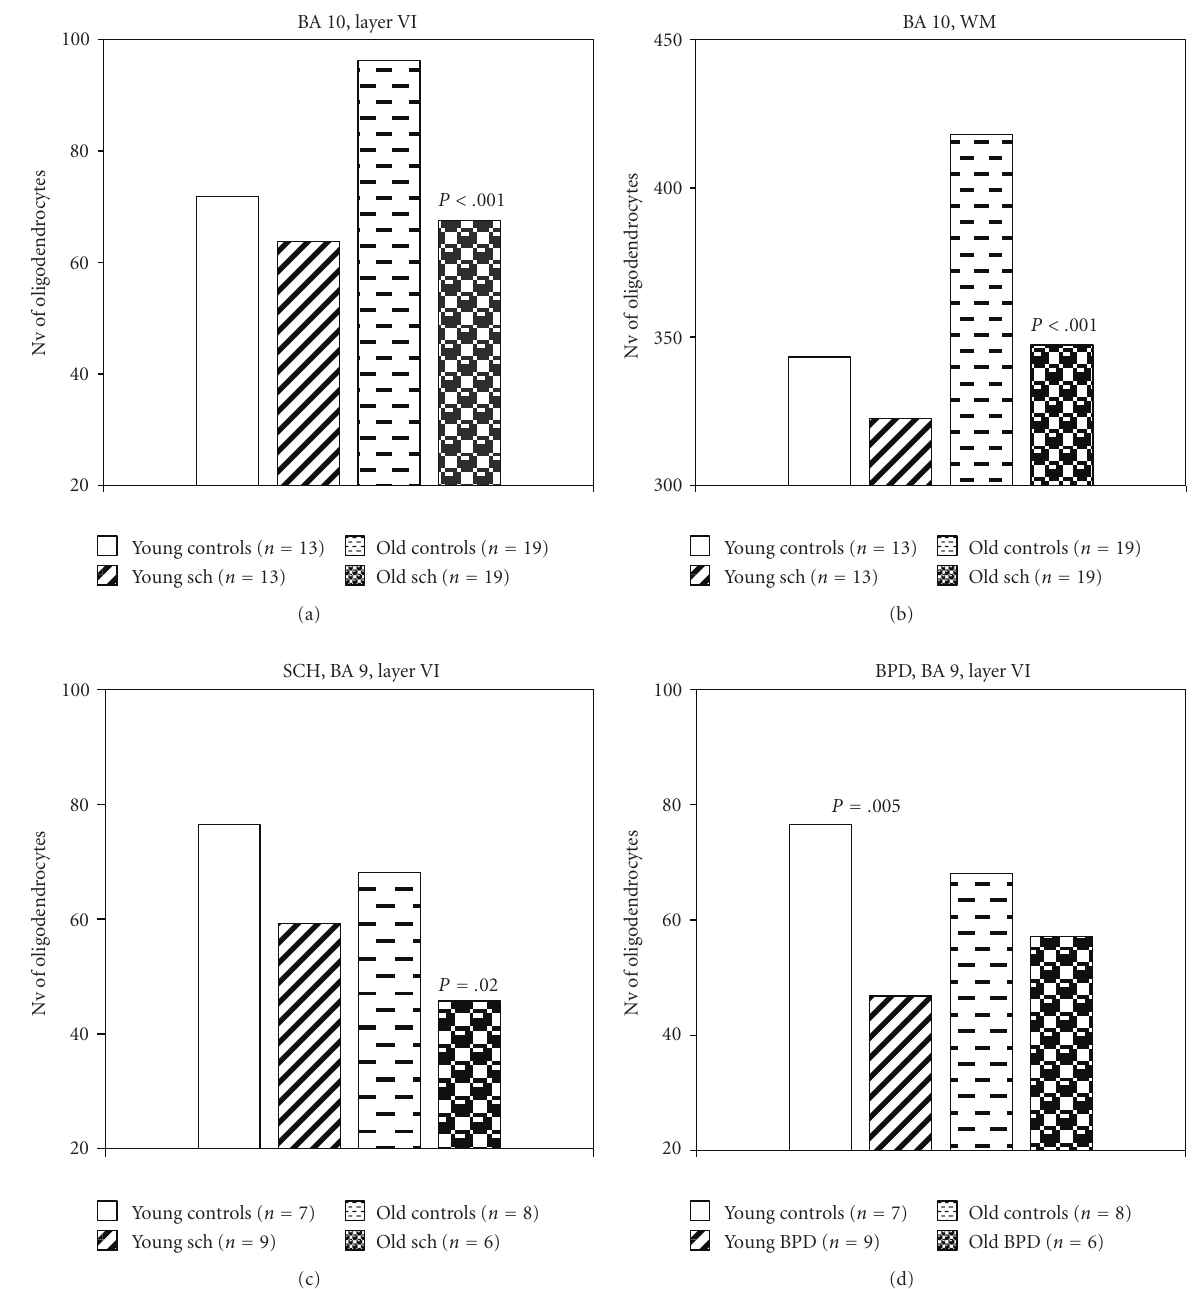
Figure 3: Plots summarizing results of comparisons of young and elderly patient subgroups with young and elderly